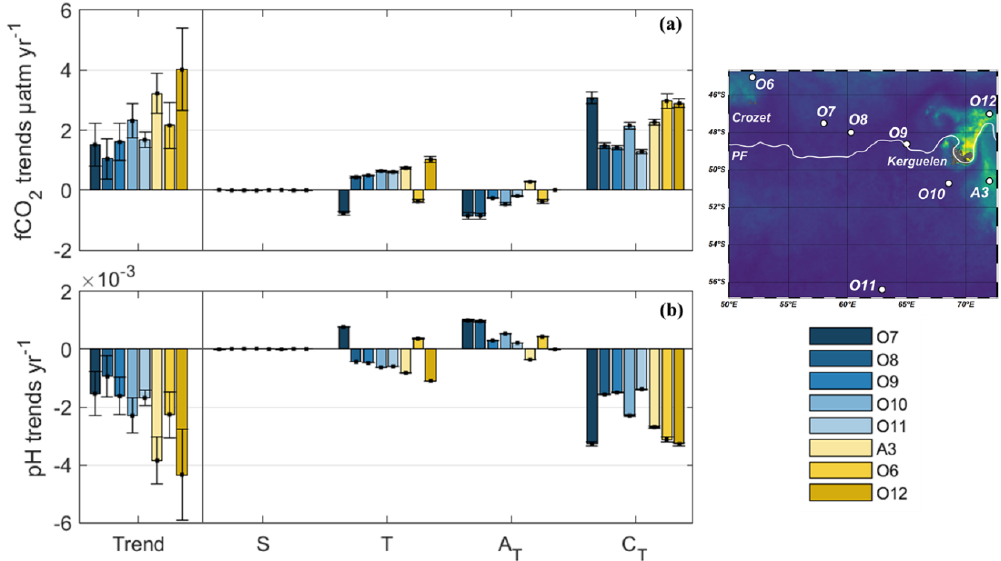
Figure 6. Trends and decomposition of fCO 2 (a) and pH (b) in the summer mixed layer, according to Eq. (9). The effect of change in salinity ( S ), temperature ( T ), A T and C T is shown. The three phytoplanktonic bloom stations are reported in yellow (last three) and are separated from the HNLC stations (first five, shown in blue). To help the interpretation, a map with the localisation of these station is included (same map as Fig. 1). Table 3. Trends (per year) evaluated in the HNLC part of (1) the north and (2) the south POOZ, from the fCO 2 surface dataset, the A T and C T surface dataset, and the A T and C T data in the mixed layer at each station (O10 and O11), estimated between (a) 1998 and 2019. The significant trends (Student’s t test) are represented in bold (at 95%) or with a star (at 90%). Temperature Salinity A